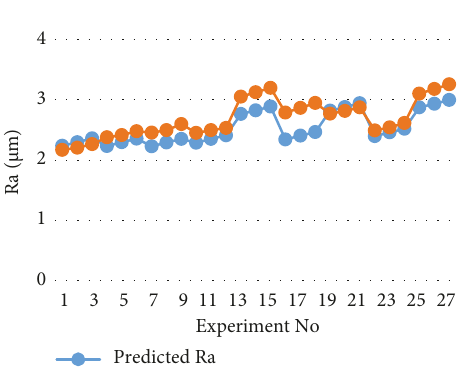
Figure 7: Actual Vs predicted MRR.